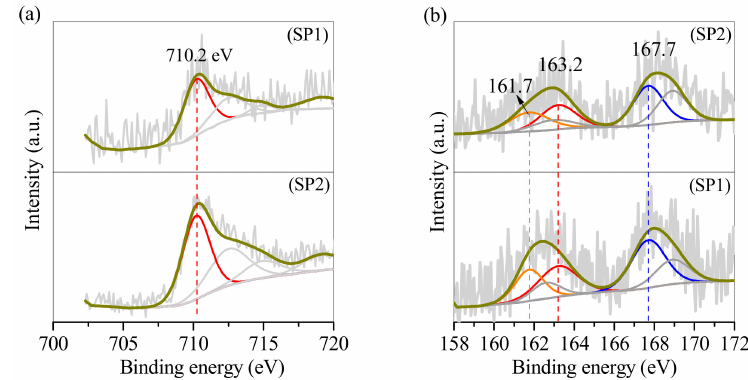
Figure 12. High resolution ( a ) Fe 2p, ( b ) S 2p XPS spectrum of SP1 and SP2 after smelting wastewater